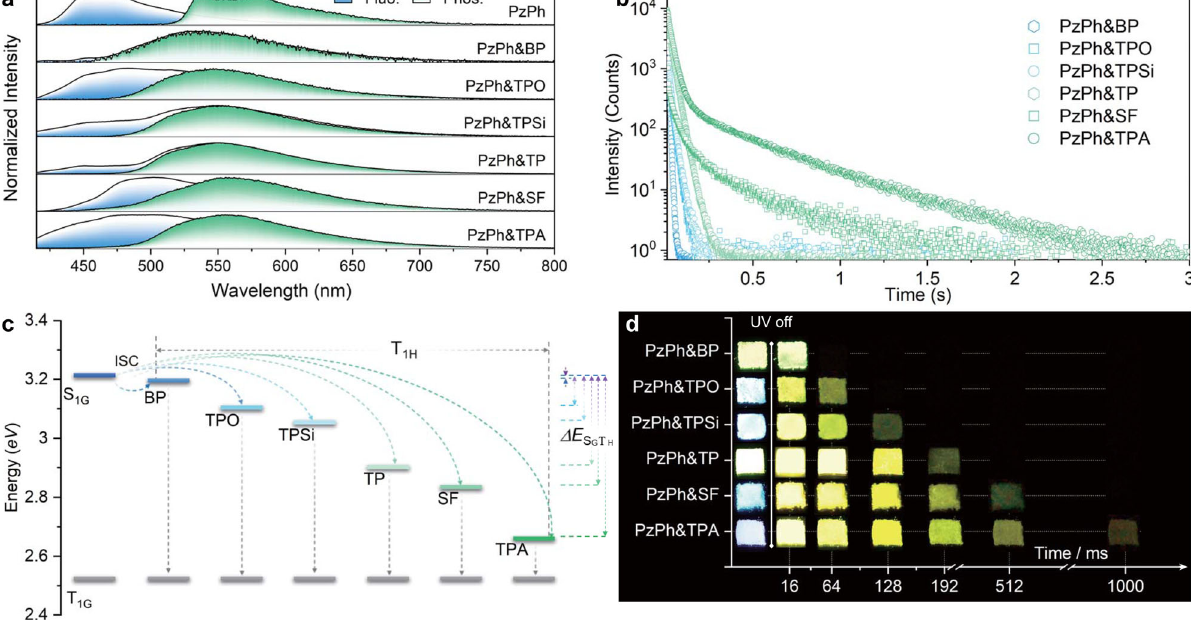
Fig. 2 Photophysical properties of crystalline powders for PzPh and the mH/G UOP system under 365 nm irradiation at room temperature. a Steady- state PL (blue fi lled, λ ex = 365 nm; PzPh&TPA was measured under 400nm irradiation) and delayed spectra (green fi lled, delayed time = 8 ms; PzPh was measured at 77 K). b Decay curves at the phosphorescence emission band of 543 – 556 nm. c The energy levels of the hosts and PzPh. d Photographs taken under a 365 nm UV lamp on and were performed. The corresponding data have been summarized in Fig. 2 and Supplementary Table 1. Phosphorescence of PzPh (obtained at 77 K) was detected as a structured band ( υ = 1395 cm − 1 ) with the emission maximum of 534 nm. After the stoppage of UV irradiation, bright-yellow afterglow was observed in the mH/G UOP system. By switching host matrices, the afterglow emission colors for the mH/G UOP system were almost unchanged with the CIE coor- dinates in the range of (0.39 – 0.42, 0.52 – 0.55) (Supplementary Fig. 9). As shown in Fig. 2a, delayed spectra of all the mH/G UOP materials featured the phosphorescence emission bands at ca. 550 nm,